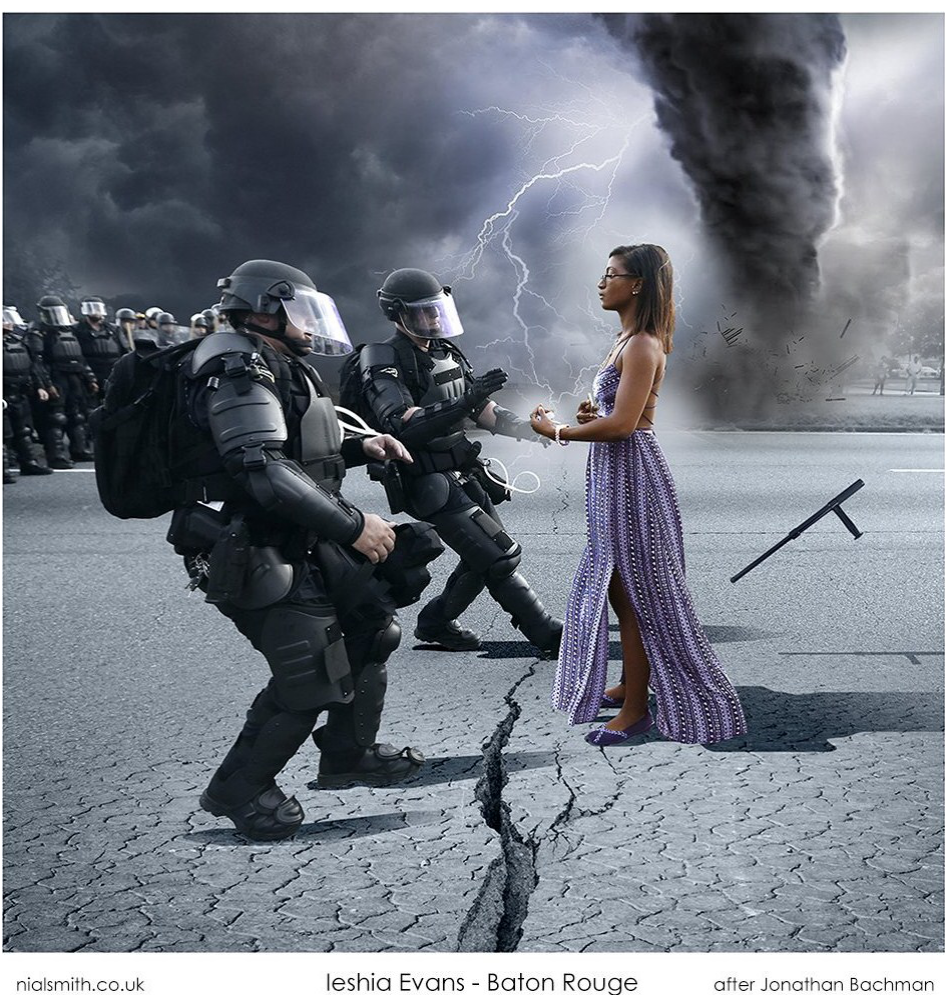
Figure 10. Ieshia Evans, supernatural being (2016). By Nial Smith. Picture courtesy of the artist.